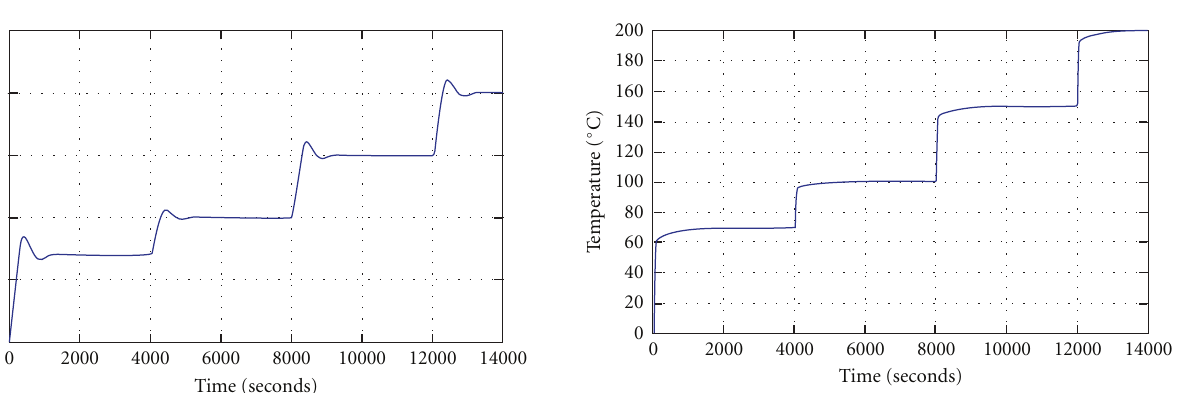
Figure 16: GA ANFIS controller simulated output at di ff erent temperature set points.